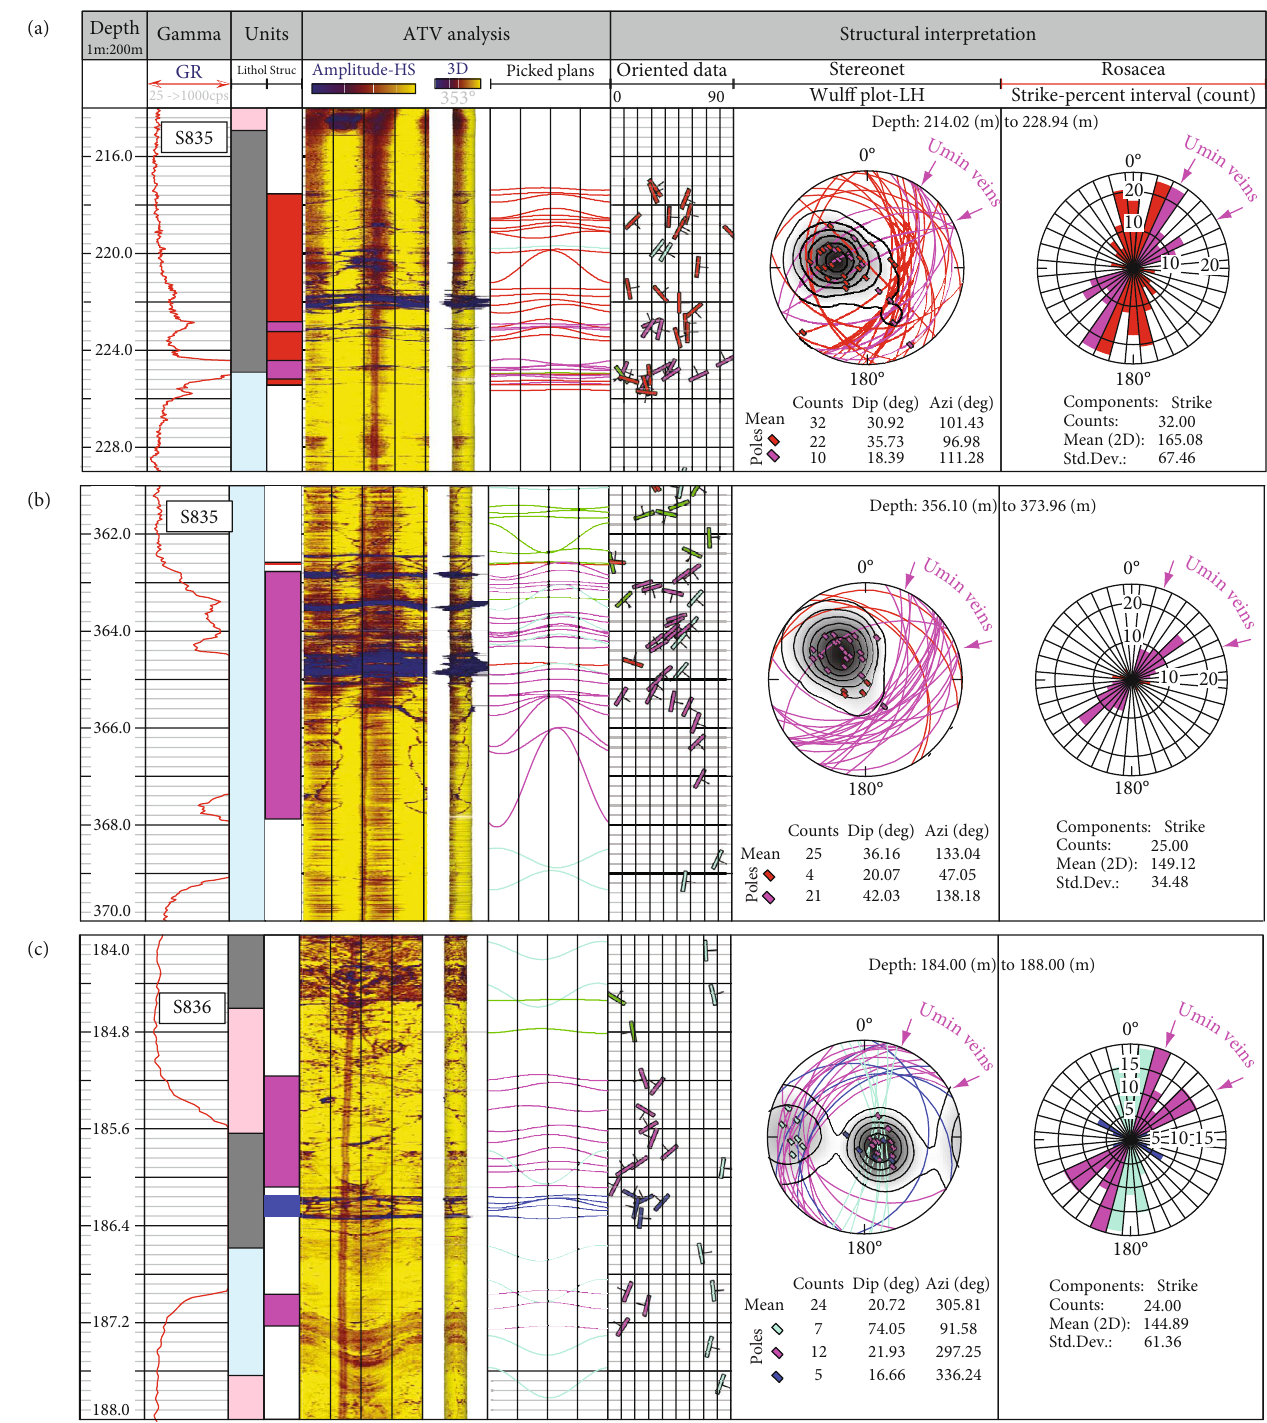
Figure 6: ATV structural analysis of the fracture/vein-related mineralization: (a) drill hole S835@225m, (b) drill hole S835@366m, and (c) drill hole S836@186m. Note the bimodal orientation and dip of the mineralized fractures and foliation for all of them. Legend in Figure